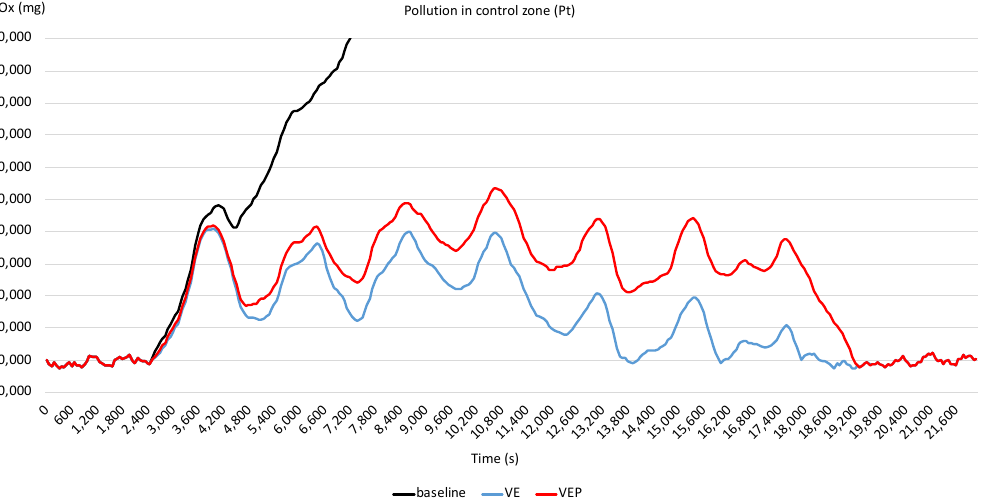
Figure 2. Evolution of the pollution (NO x ) in the control zone during the simulation of parking access with constant arrival rates.